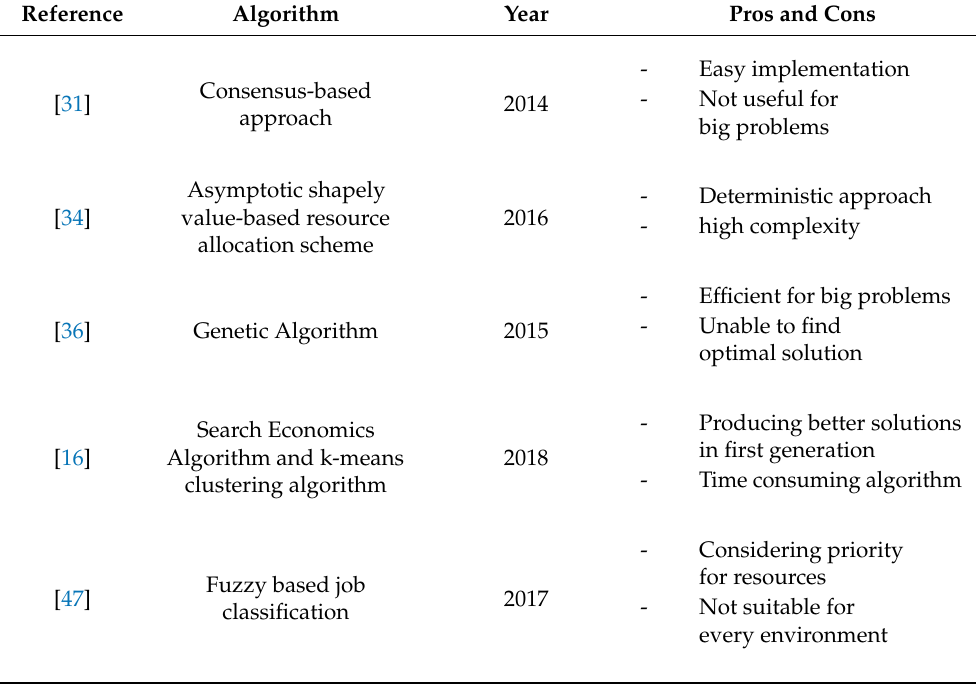
Table 1. A summary of related